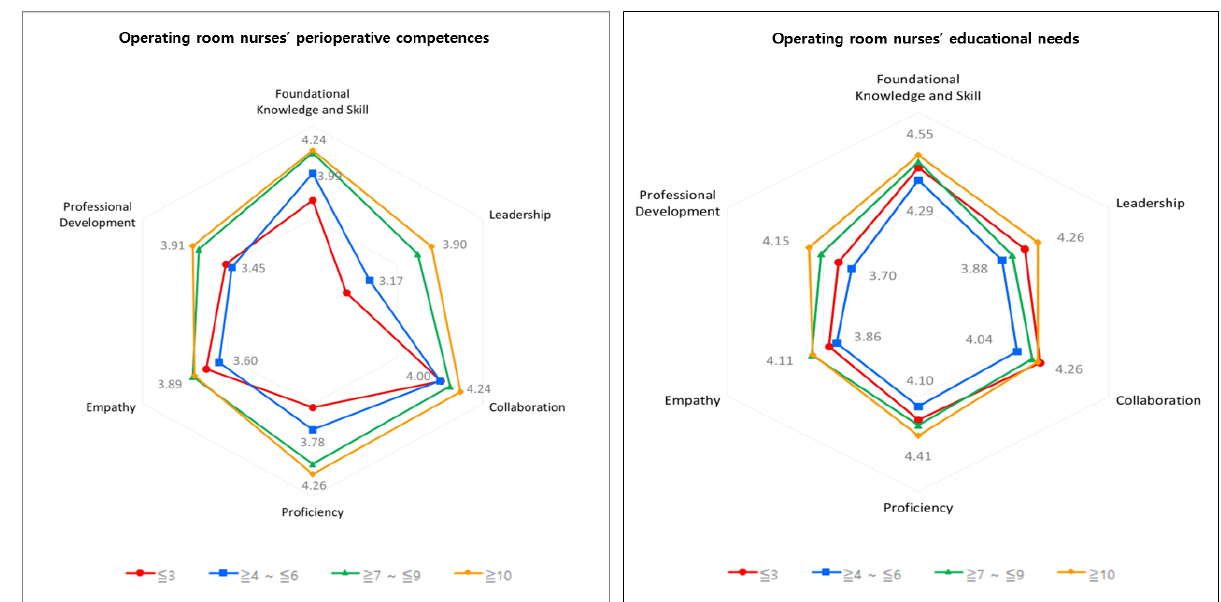
Figure 1. OR nurses’ perioperative competencies and educational needs .